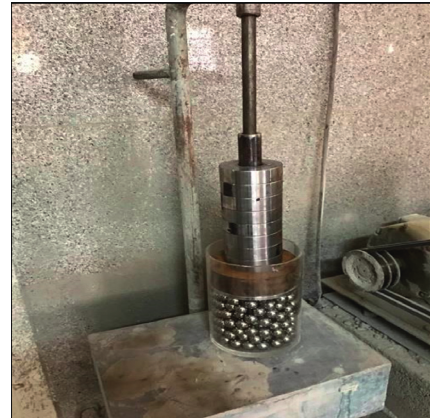
Figure 5: An example of Torabi L-Box experiment.